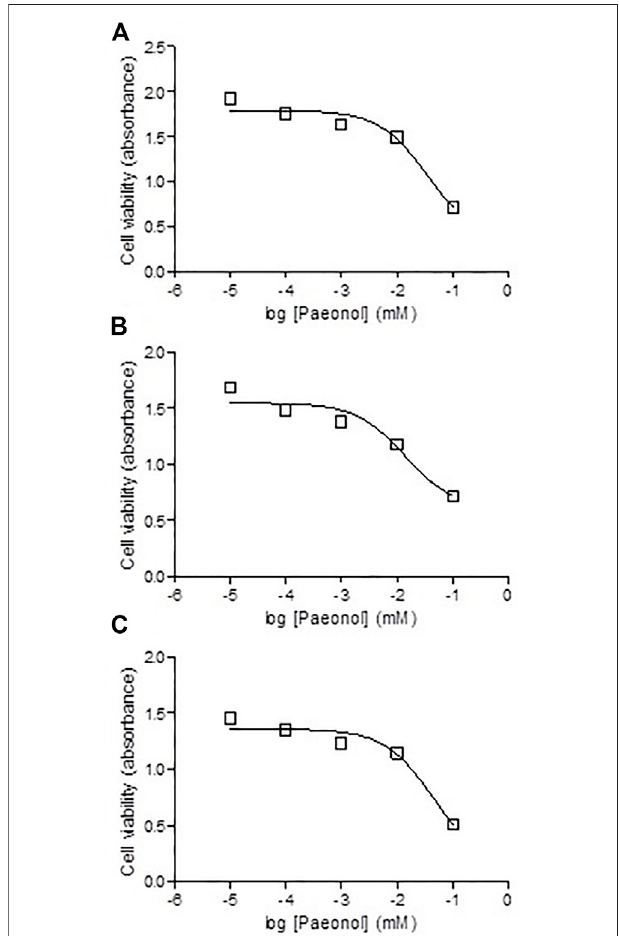
FIGURE 8 | Effect of coadministration of paeonol and methotrexate (MTX)oncytotoxicityincoloncancercells.Paeonolwasadministeredtocolon cancer cells in concentrations ranging from 0.01 to 100 μ M concomitantly with MTX in concentrations of (A) 0.1, (B) 1, or (C) 10 μ